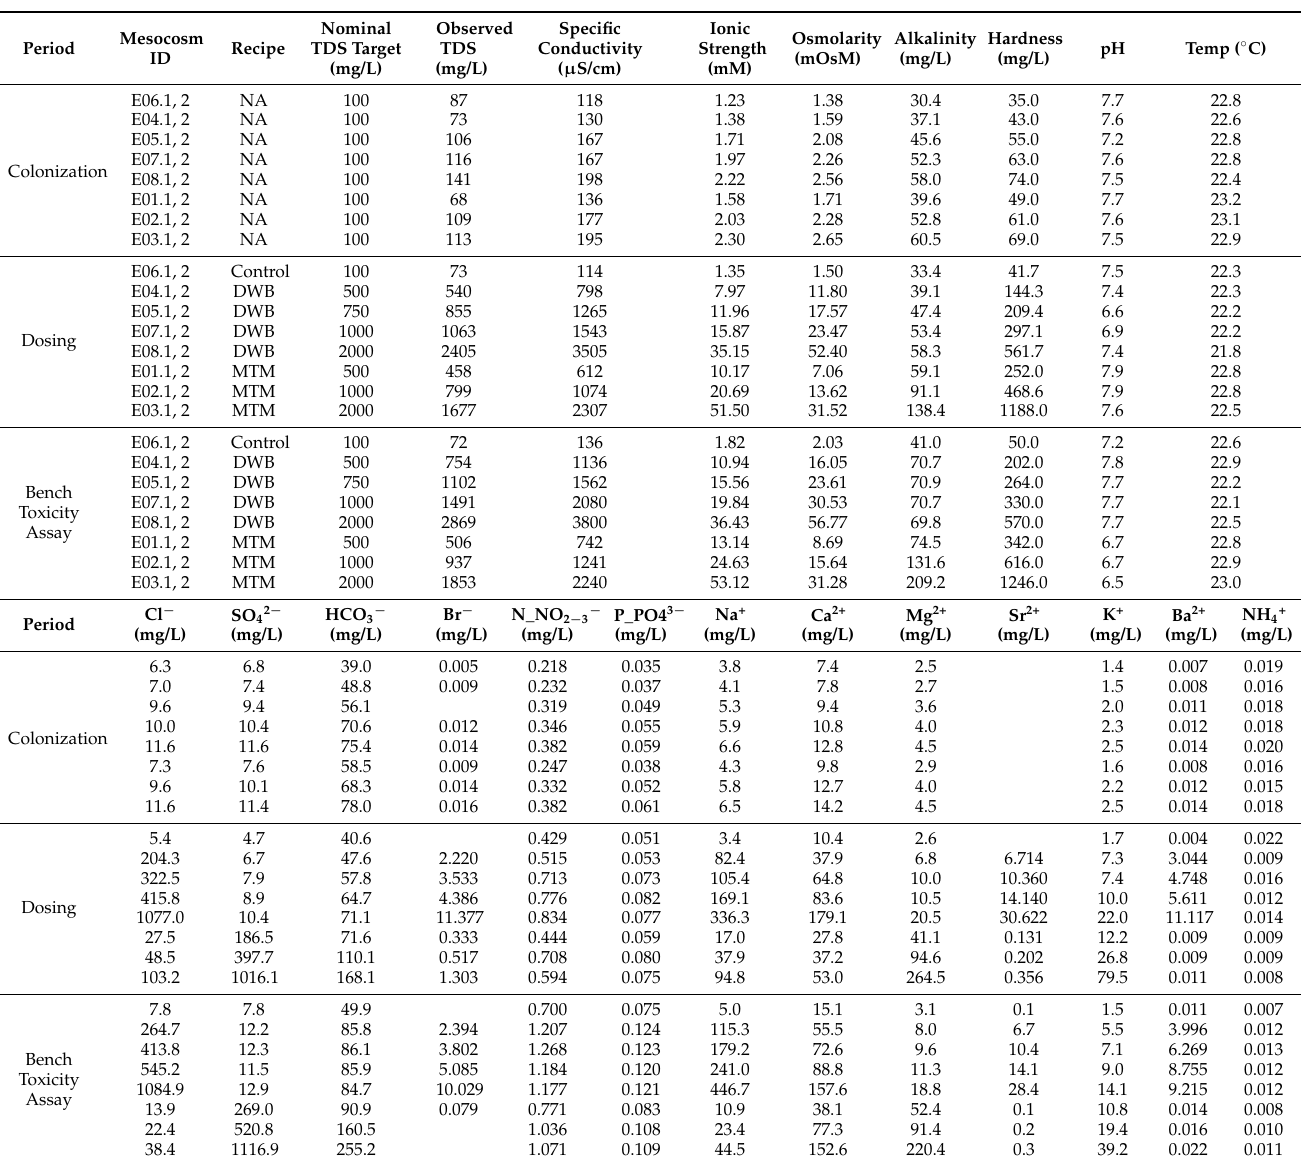
Table 1. Mesocosm surface water chemistries averaged among replicates and within experimental periods. BD = below detection or